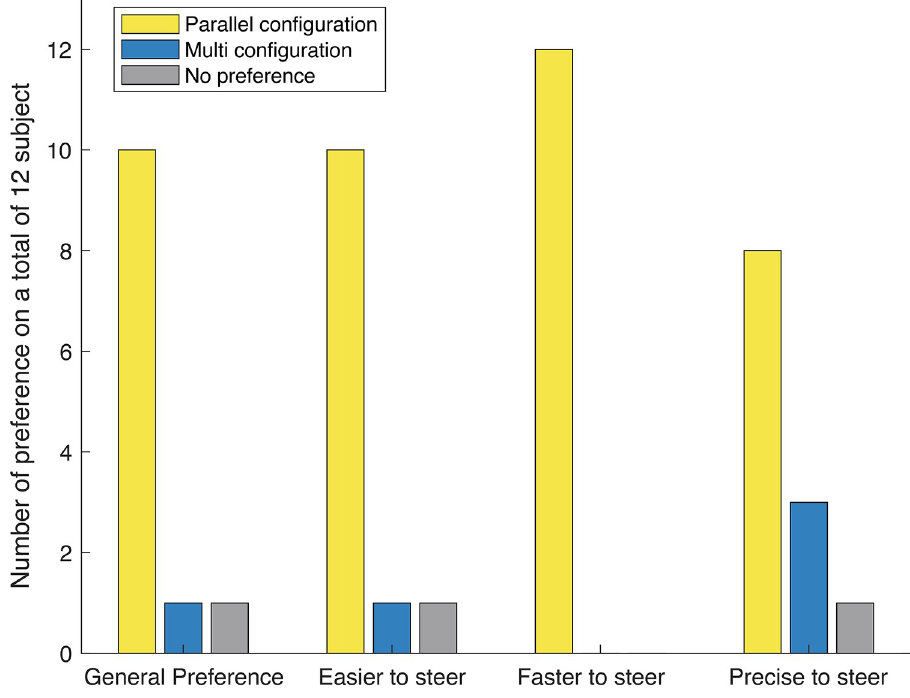
Fig 12. Results of the final questionnaire on personal